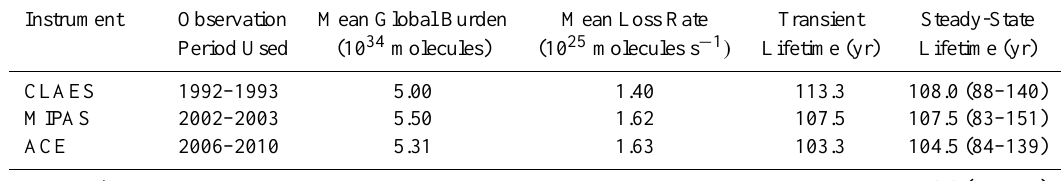
Table 2. CFC-12 lifetimes based on global satellite